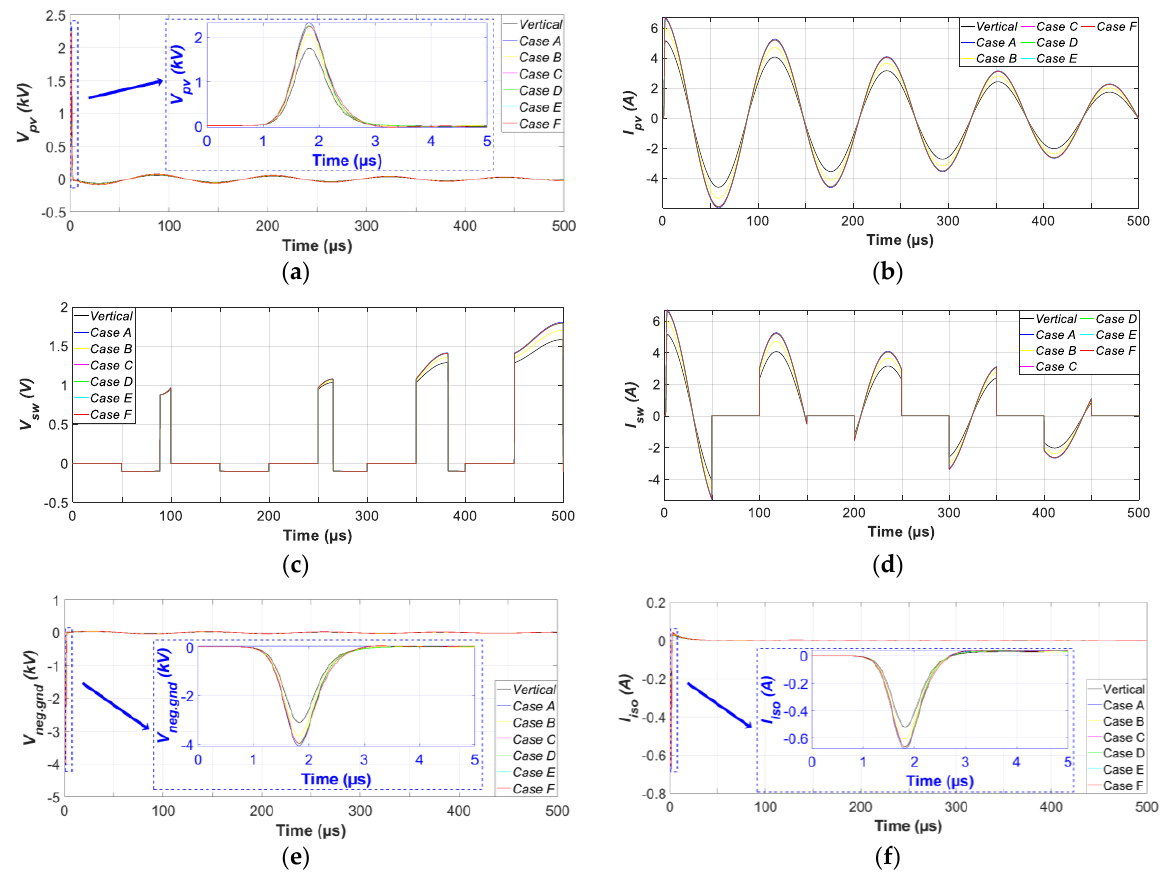
Figure 15. Case of various channel tortuosity, voltages and currents induced in some components of converter-PV module assembly: (a) induced voltages at the PV module; ( b ) PV current output; ( c ) switch voltage; ( d ) current across the switch; ( e ) voltage of negative output terminal to ground; ( f ) module insulation current.